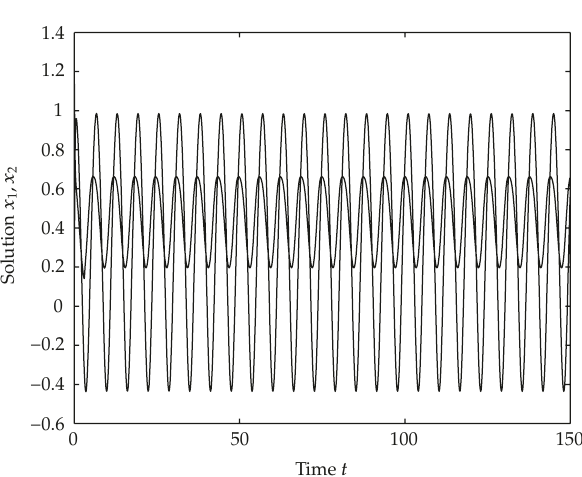
Figure 1: Numerical solution x 1 (cid:6) t (cid:7) , x 2 (cid:6) t (cid:7) of system (cid:6) 4.1 (cid:7) , where τ 11 (cid:6) t (cid:7) (cid:8) 5 , τ 12 (cid:6) t (cid:7) (cid:8) 2 , τ 21 (cid:6) t (cid:7) (cid:8) 3 , τ 22 (cid:6) t (cid:7) (cid:8) 6, x 1 (cid:6) s (cid:7) (cid:8) − 0 . 2 , x 2 (cid:6) s (cid:7) (cid:8) 1 . 4 for s ∈ (cid:4) − 6 , 0 (cid:5)